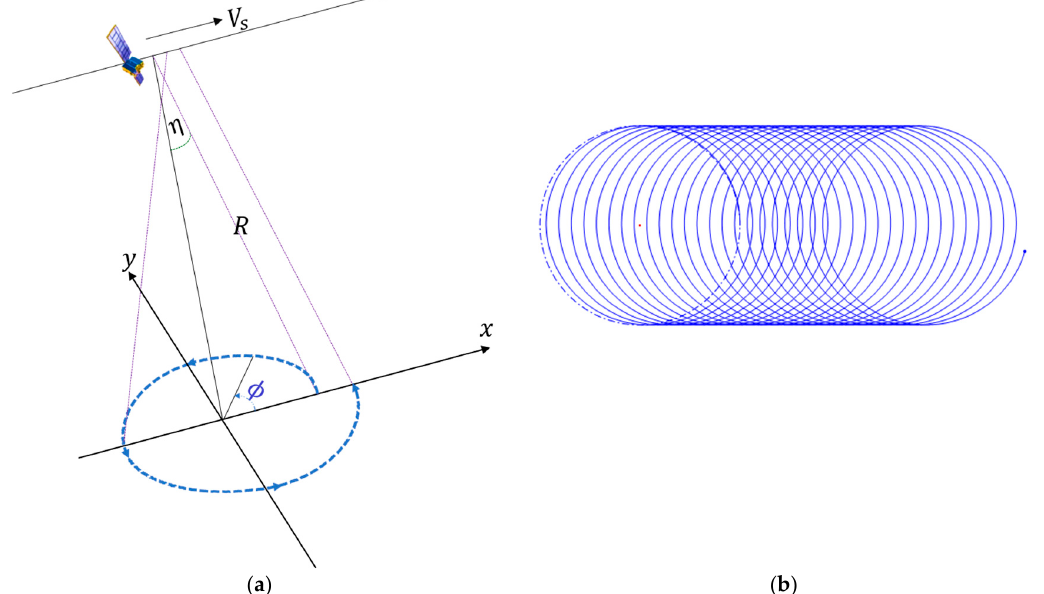
Figure 1. Illustration of the observation geometry. ( a ) Scanning geometry; ( b ) Surface coverage of beam trajectory .